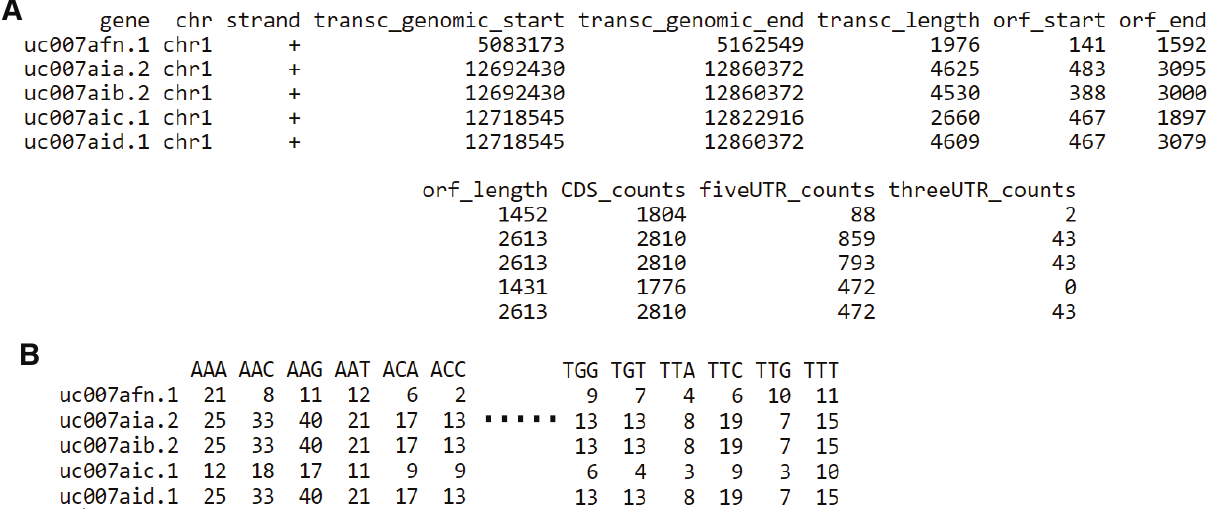
Figure 3. Output tables of ‘ RiboProfiling’ package on the G�M1������� dataset. A , Quantifi�ation of Ribo-seq read �overage on the CDS, 5�� UTR and 3�� UTR regions of protein �oding genes�� B �� Quantifi�ation of Ribo-seq �overage on �odons��